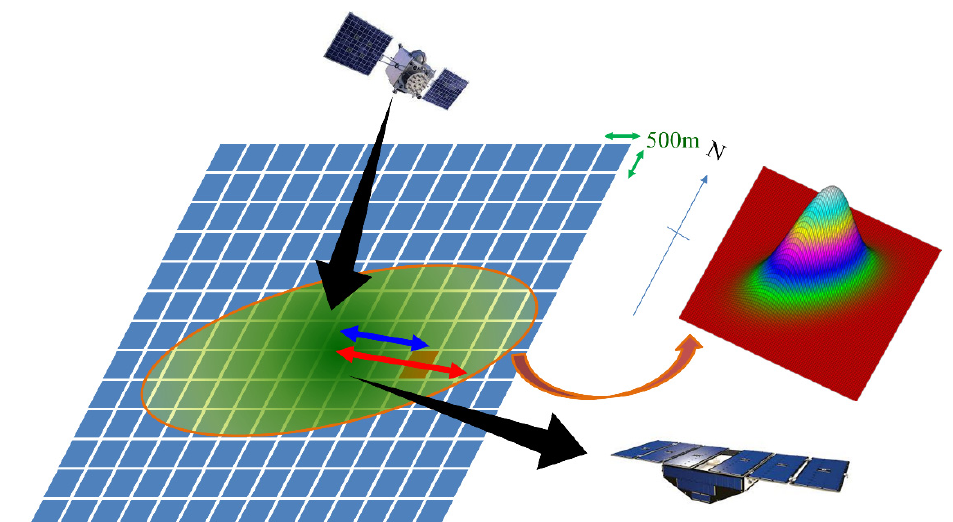
Figure 2. Illustration of the precision index. The light blue tiles are rasterization grid cells. The yellow circular area is the effective scattering area. The red tile in the yellow/green circle effective scattering area is the corresponding grid. The green, blue and red arrows are equivalent to the GS , DistSP and SemiDSP terms in Equation (2).